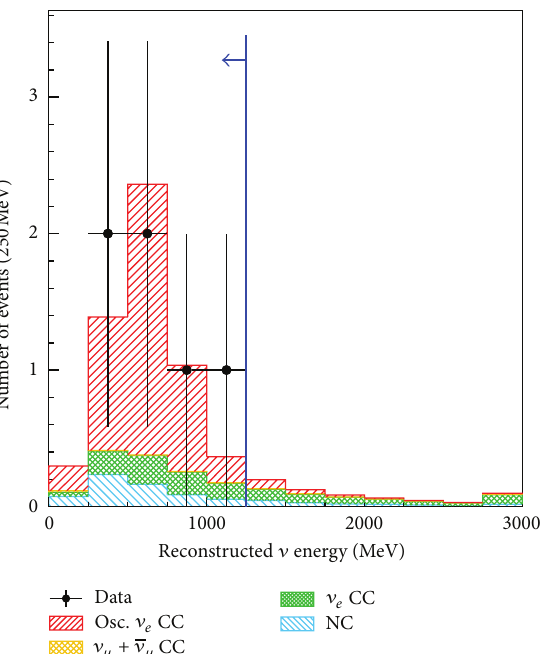
Figure 20: Reconstructed neutrino energy 𝐸 rec 𝜈 spectra for T2K 𝜈 𝑒 appearance search. The black points show the 6 candidate events observed in SK using 1.43 × 10 20 POT data. Using sin 2 (2𝜃 13 ) = 0.1 the red histogram is the predicted appearance signal, the expected background shown in yellow is for muon neutrinos, green is for the electron neutrinos intrinsic to the beam, and blue is for the NC events.